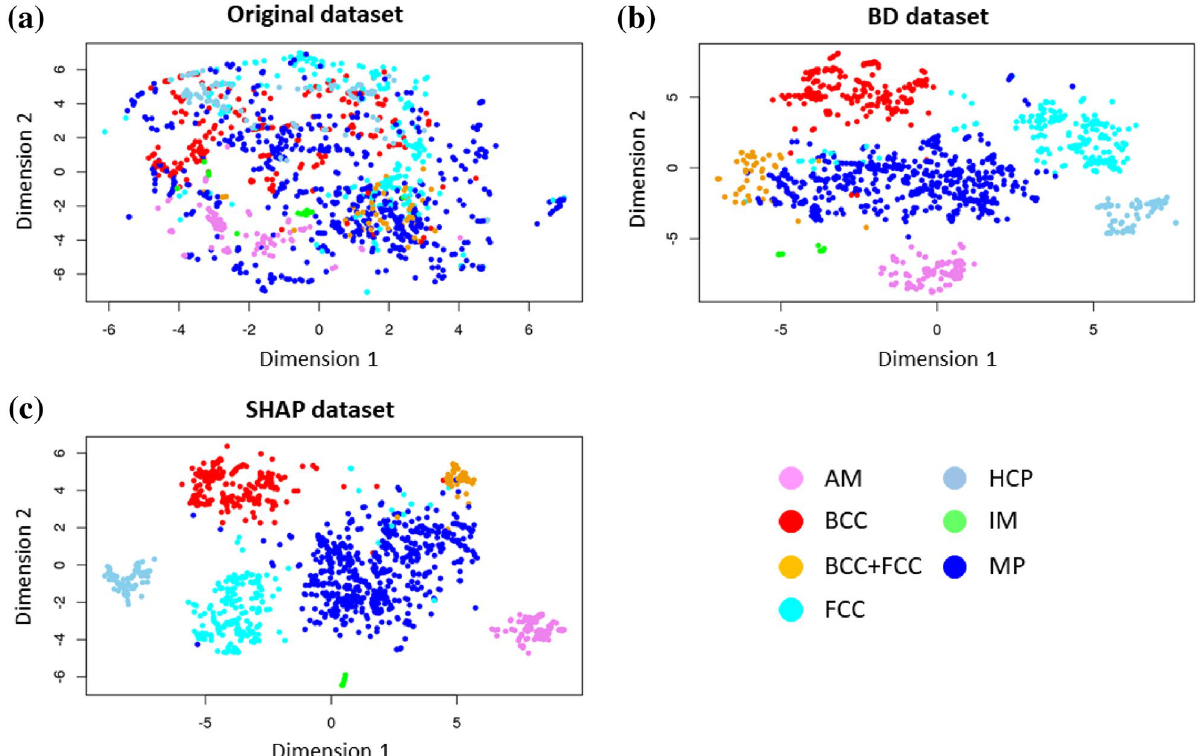
Figure 2. Three different high-dimensional datasets visualized using the t-SNE algorithm: ( a ) original or raw data, ( b ) BD, and ( c )